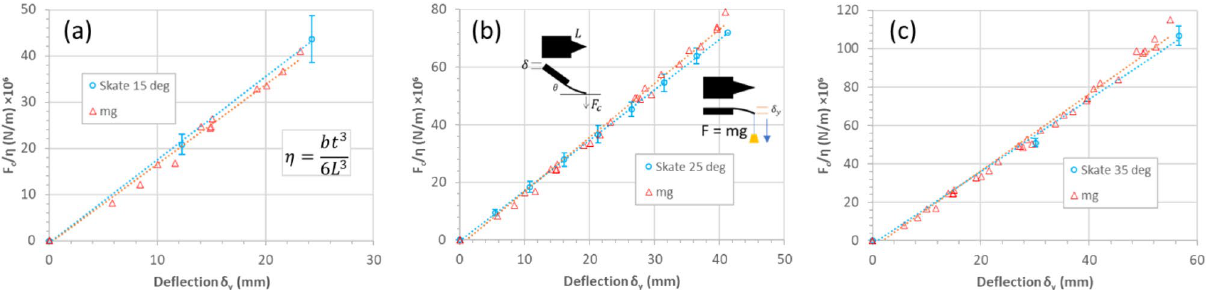
Figure 10. Comparison of cantilever deflection due to concentrated loading (red triangles) and overtravel/skate (blue circles) experiments. The plots correspond to cantilever tilt angles of ( a ) 15°, ( b ) 25°, and ( c ) 35° in the case of